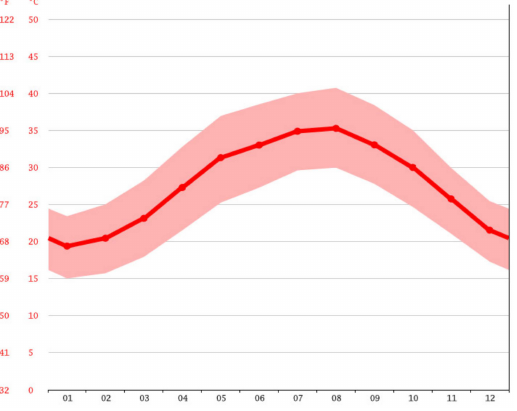
Figure 2. Temperature range for Abu Dhabi.